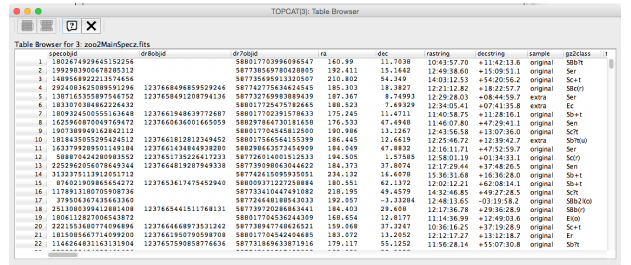
Fig. 53.— The TOPCAT main window with table data loaded